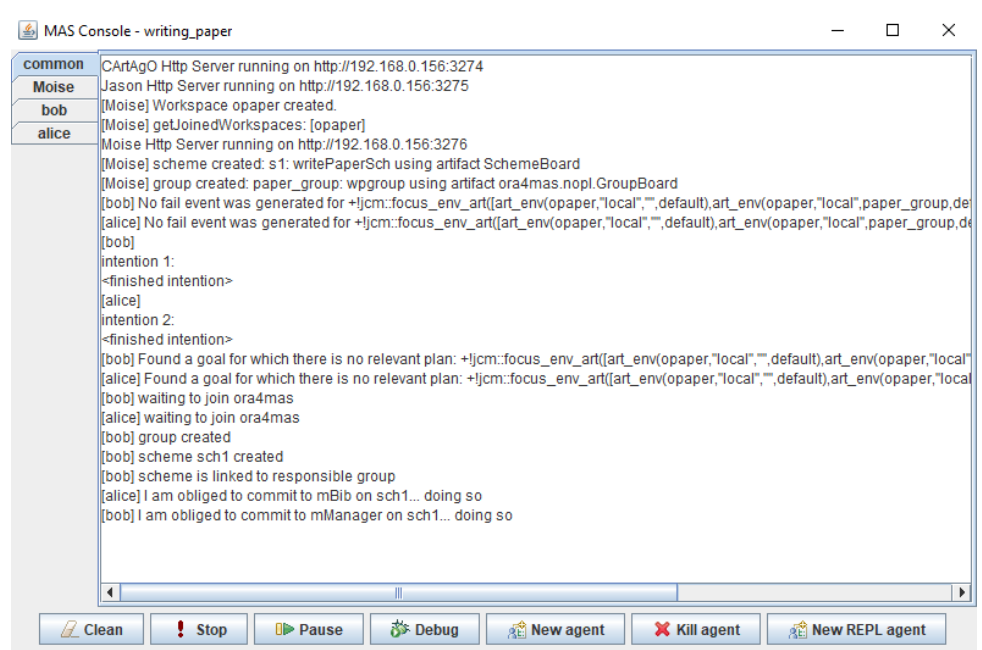
Figure 21. JaCaMo interface for simulation error example—permission for an agent not eligible for the